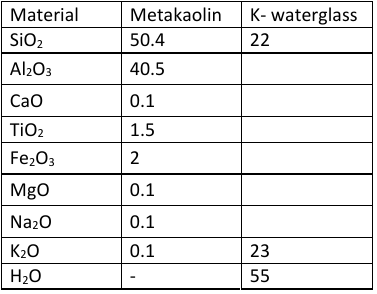
Table 1. Chemical composition of Metakaolin and K ‐ based silicate solution